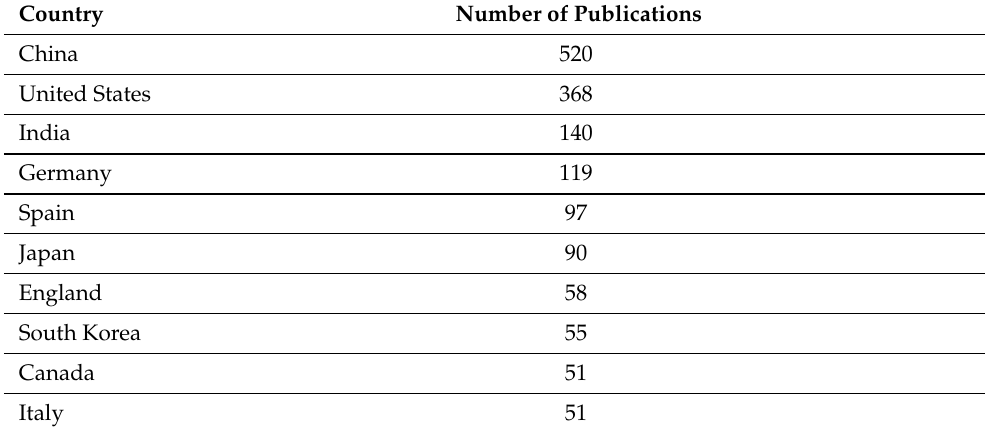
Table 2. Most productive